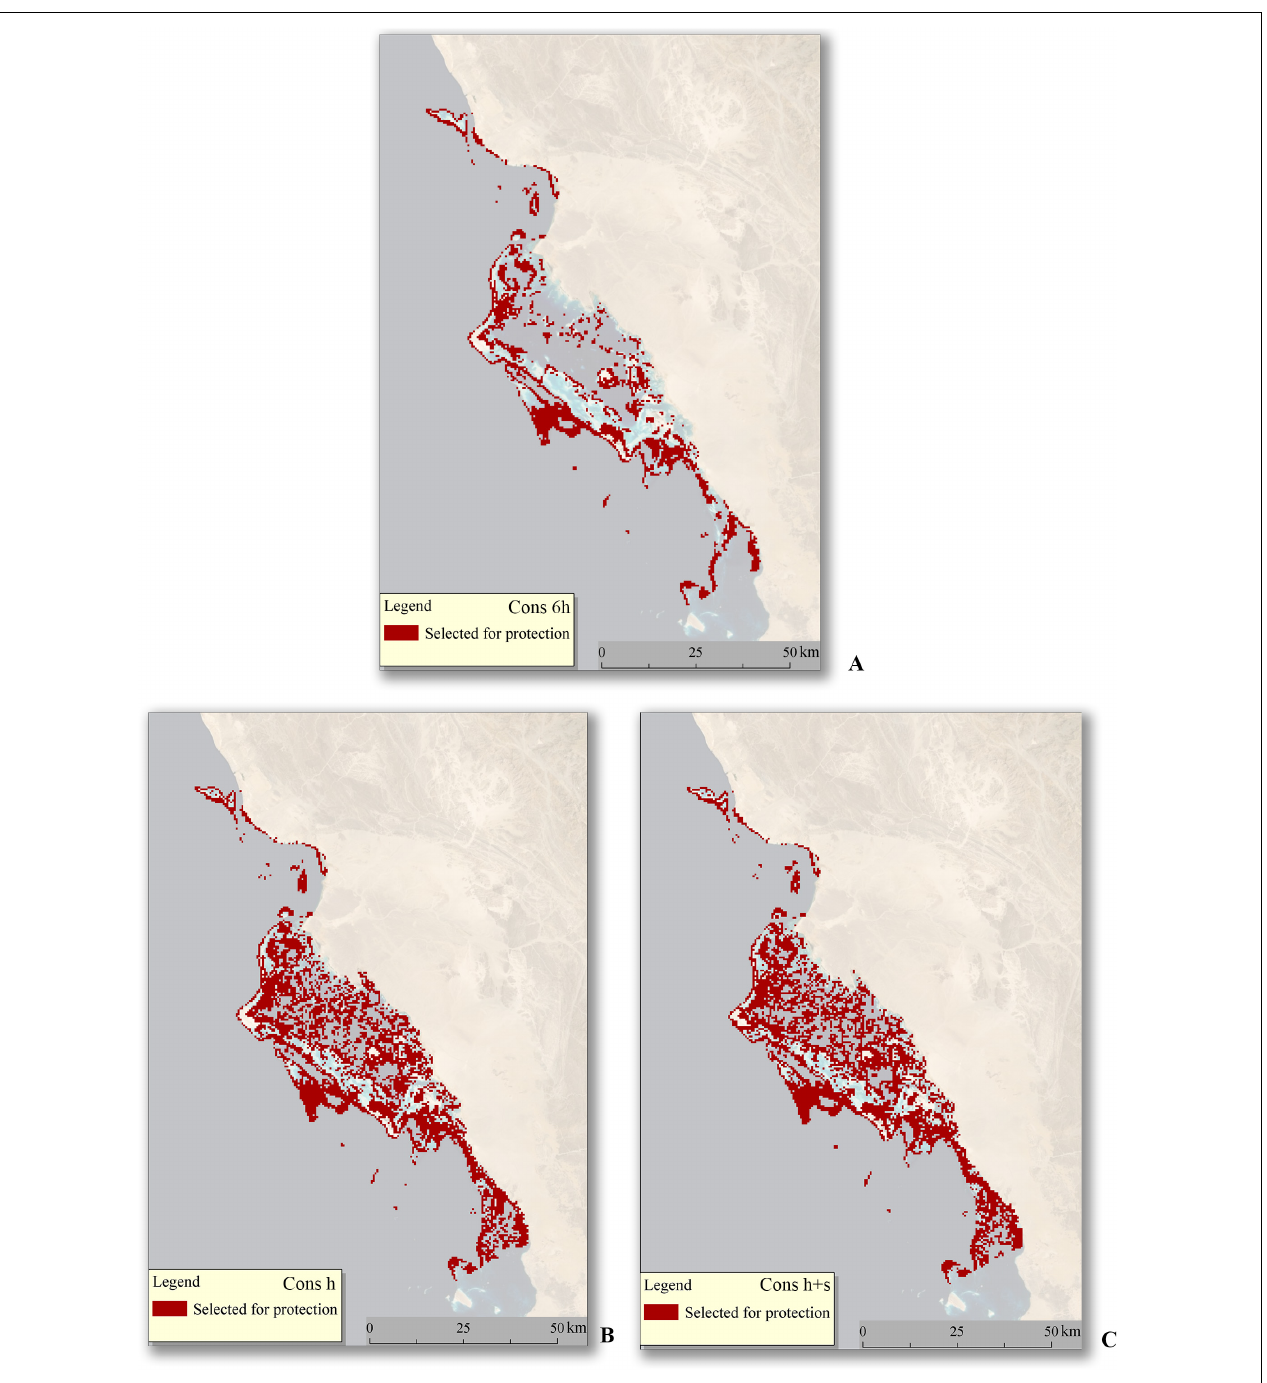
FIGURE 2 | Spatial distribution of the selected planning units (PUs). The total area of the site was 2,081 km 2 . (A) For the “Cons_6h” scenario, where targets only for six key habitats were considered, the area selected for protection was 684 km 2 . (B) For the “Cons_h” scenario where targets were set for 17 habitats, the area selected for protection was 1,214.8 km 2 . (C) For the “Cons_h + s” scenario where targets were set for 17 habitats and 11 species, the area selected for protection was 1,232.5 km 2 .